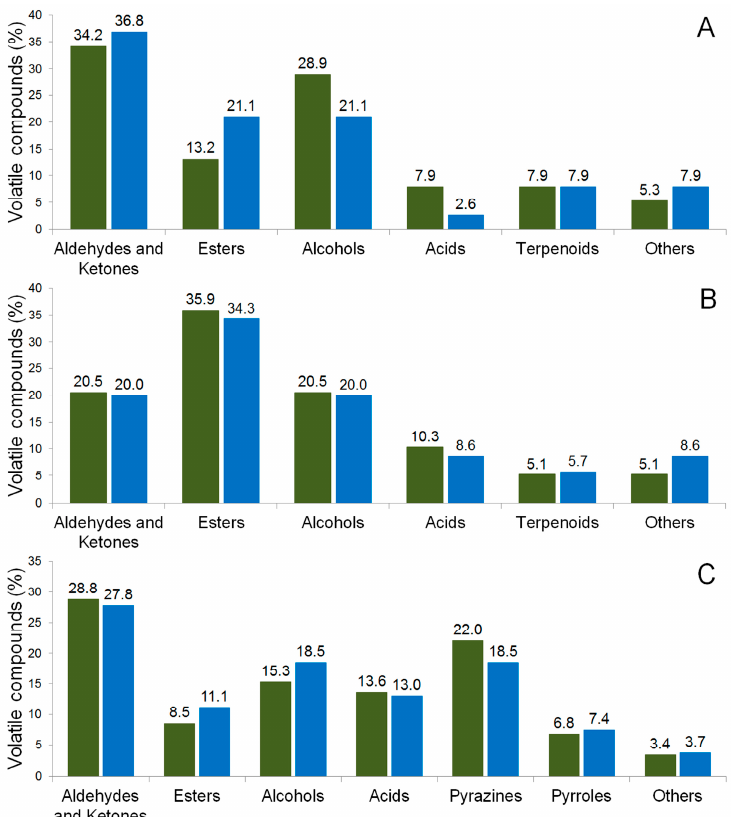
Figure 4. Profile of volatile compounds identified by HS–SPME GC–MS during non–inoculated fermentation ( PH15 NI), inoculated fermentation ( PH15 I), and in the chocolate samples. Fermentation times: 0 h ( A ) and 144 h ( B ). Chocolate samples ( C ). Total amount of compounds: PH15 SI 0 h (37), PH15 SI 144 h (38), PH15 SI Ch (58), PH15 I 0 h (37), PH15 I 144 h (34), and PH15 I Ch (54).